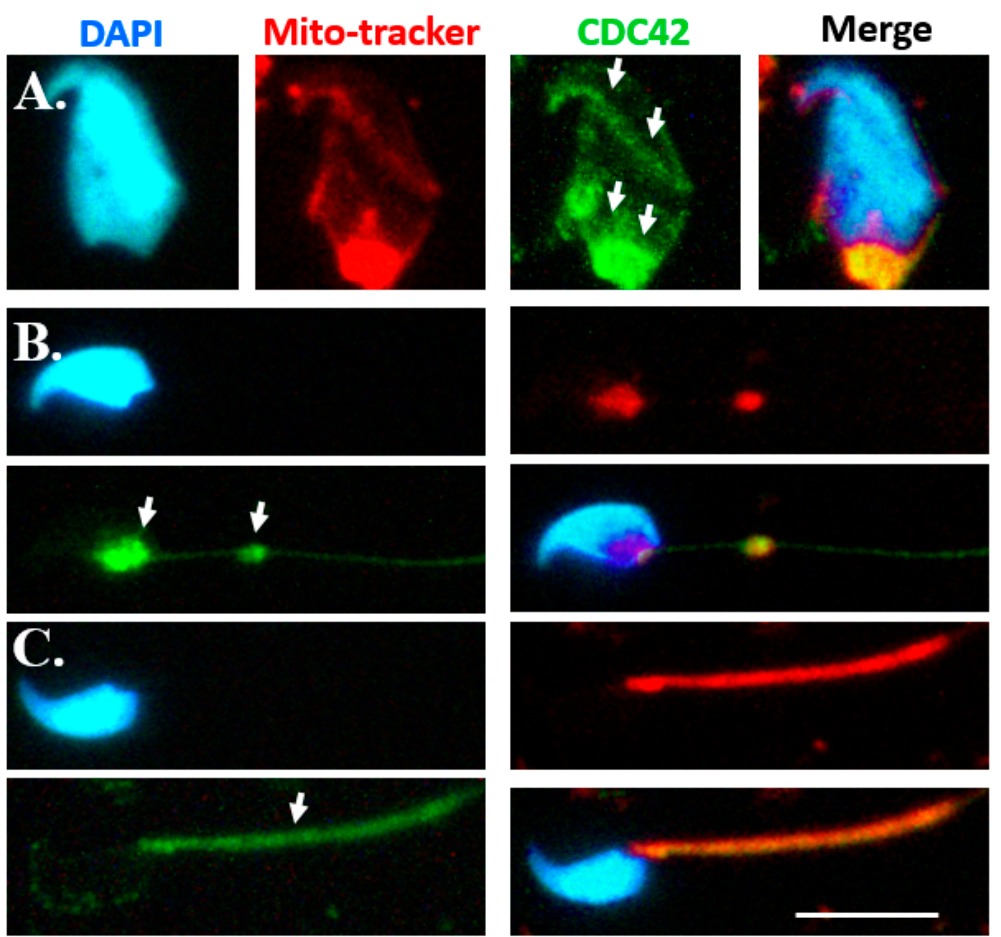
Figure 2. CDC42 localization during murine spermiogenesis. Immunofluorescence (IF) staining results revealed multiple localizations of CDC42 signals: ( A ) elongating spermatids, ( B ) elongated spermatids, and ( C ) mature spermatozoa. Nuclear staining (“DAPI” panels), mitochondria labeling (“Mitotracker”), anti-CDC42 antibody (“CDC42” panels), and a combination of DAPI, Mitotracker, and anti-CDC42 antibody (“Merge” panels) were used as stains. Arrowheads indicate CDC42 localizations. Scale bar = 10 μ m.